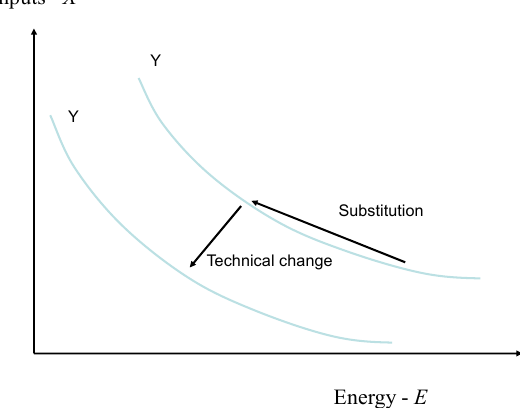
Figure 1. Substitution and neutral technical